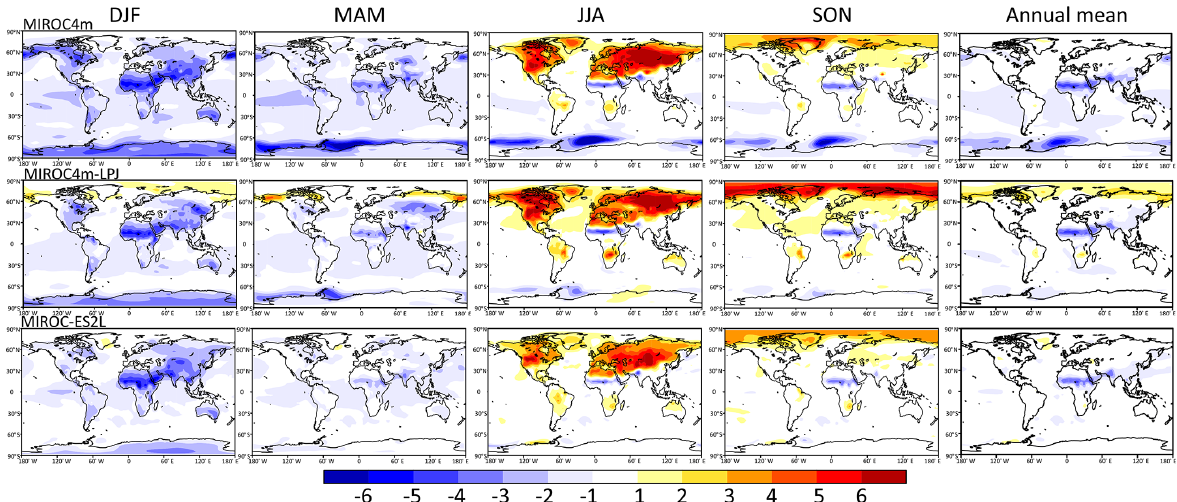
Figure 4. Seasonal and annual surface air temperature difference (K) between 127k and PI in three models. The calendar for 127k is adjusted using a method based on Bartlein and Shafer (2019).